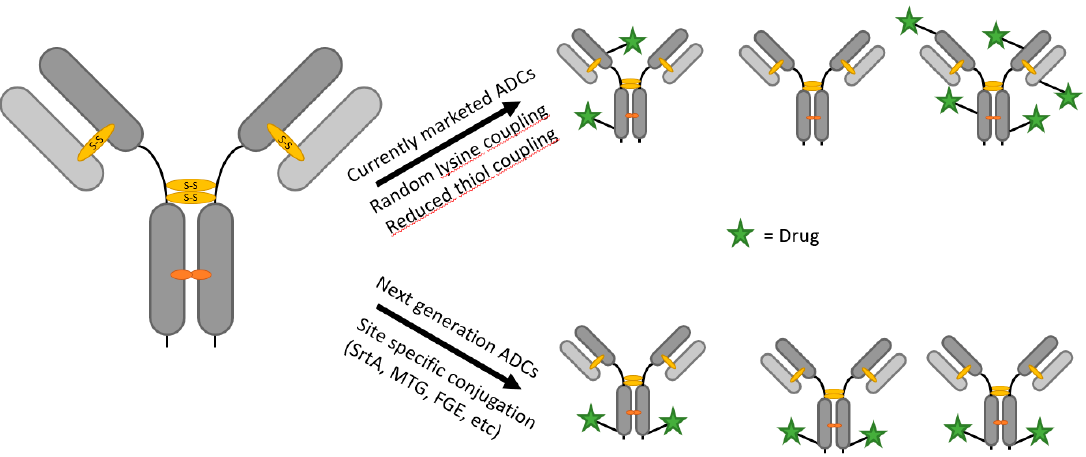
Figure 1. Depiction of unspecific chemical coupling and controlled chemo-enzymatic coupling.